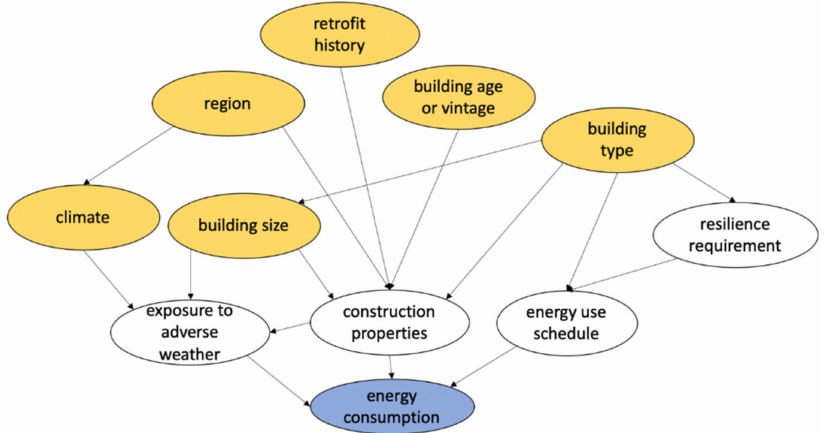
Figure 3. Variables affecting energy consumption (variables in yellow are the control variables).